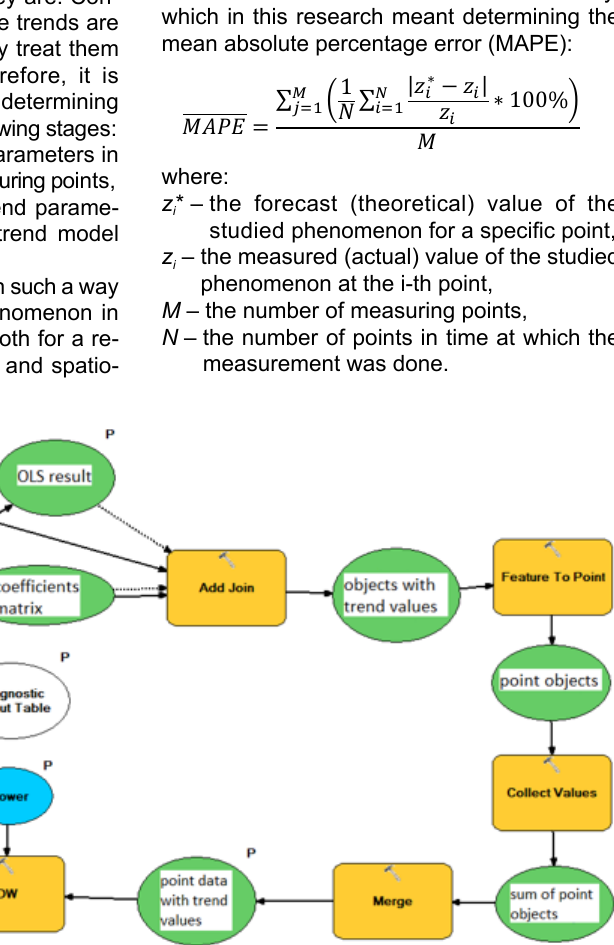
6. Methodology and its implementation The proposed methodology for modeling spatio-temporal trends rests on the assumption that temporal trends, no matter how spatially differentiated, also have a certain correlation in space. Per Tobler's law, the closer they are to each other, the more similar they are. Consequently, the parameters of these trends are correlated spatially; thus, one may treat them as a regionalized variable. Therefore, it is possible to divide the process of determining spatio-temporal trends into the following